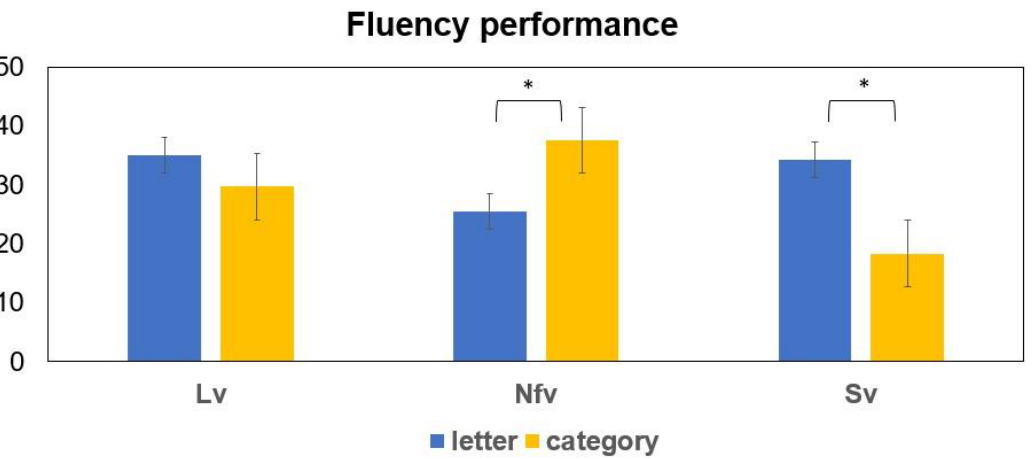
Figure 1. Behavioral scores of letter fluency and category fluency (accuracy is shown in percentage with standard error for both tasks) for the PPA variants (Lv = logopenic variant; Nfv = nonfluent variant; Sv = semantic variant), in the two fluency tasks (letter and semantic fluency). * p < 0.01. Table 2. Behavioral scores of letter fluency and category fluency (in percentage of correct responses with standard deviations in parentheses for both tasks) for all of the PPA patients and variants. Task differences: a = Nfv significantly impaired in letter compared to category fluency performance; b = Sv significantly impaired in semantic compared to letter fluency performance ( p ≤ 0.05 with Bonfer- roni Tukey post-hoc corrections).